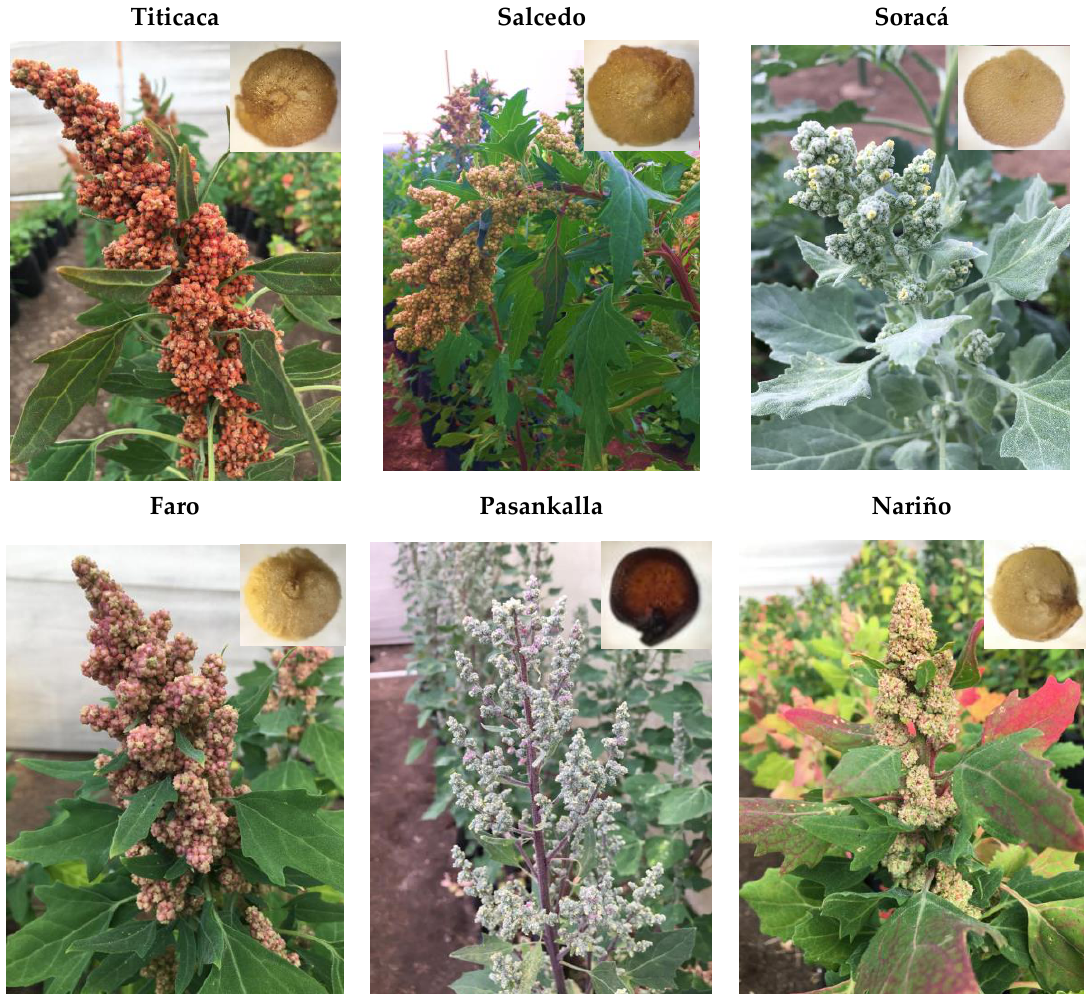
Figure 1. Macroscopic grains image from different cultivars in Colombia.